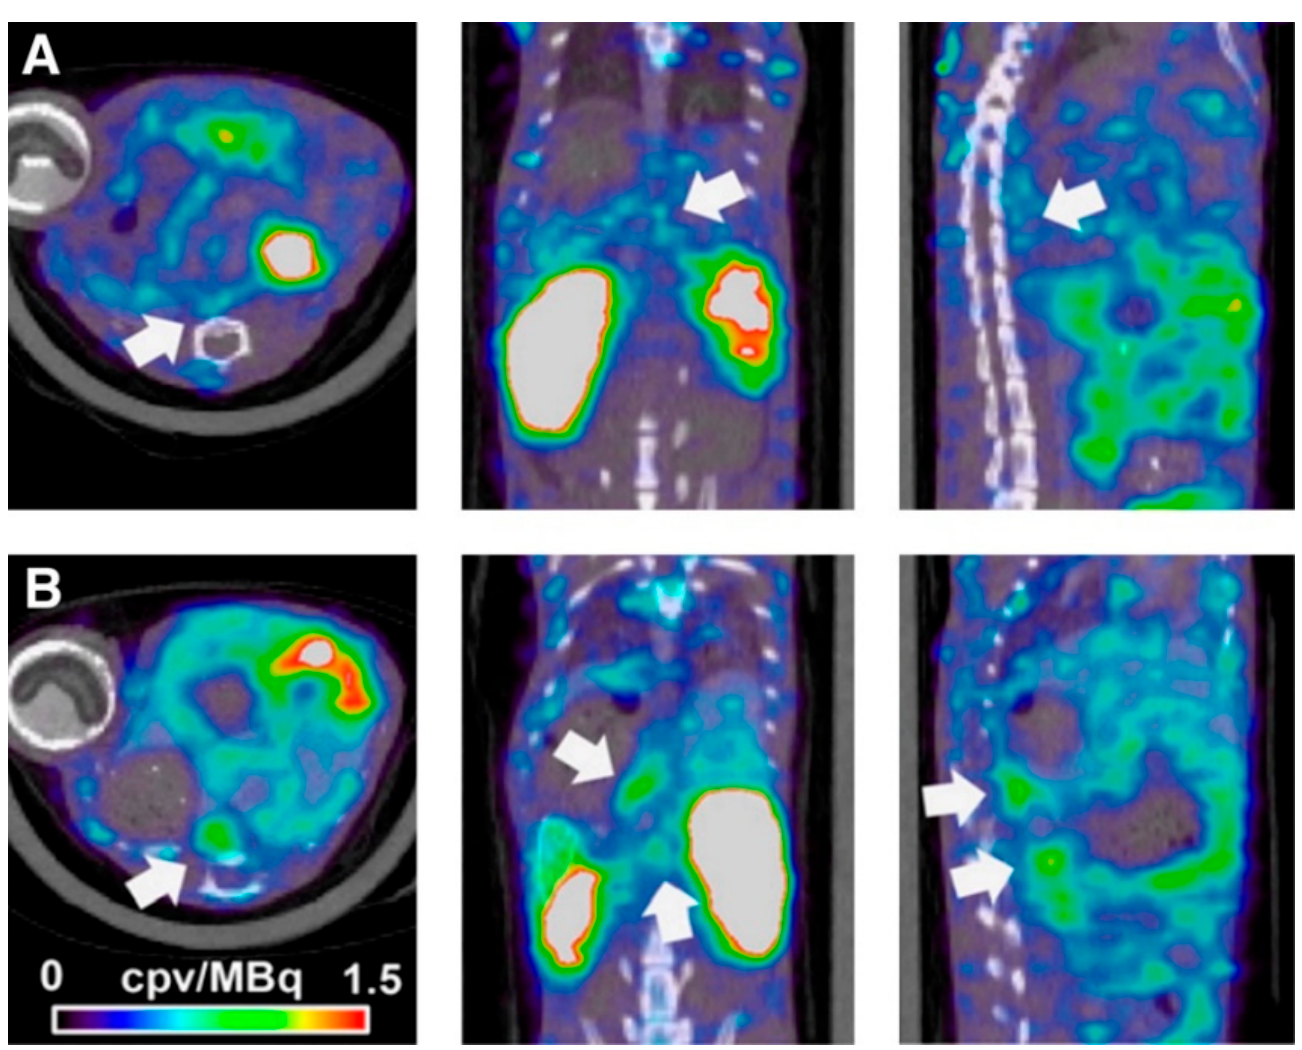
Figure 3. Example images for 99mTc-RYM1 imaging of AAA. A and B show examples of fused 99mTc-RYM1 SPECT/CT images from mice with little ECM remodeling ( A ) and aneurysm ( B ) groups, classified on the basis of visual in situ analysis of the abdominal aortae. Transversal (left), coronal (middle), and sagittal (right) views are provided. Arrows indicate the areas of maximal tracer uptake within the abdominal aortae. Adapted from Toczek et al. [32] © SNMMI.